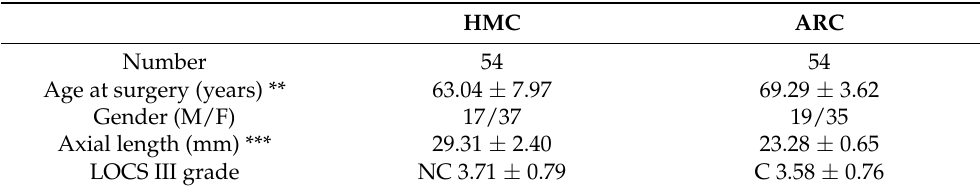
Table 1. Basic information of lens epithelium sample donors involved in this